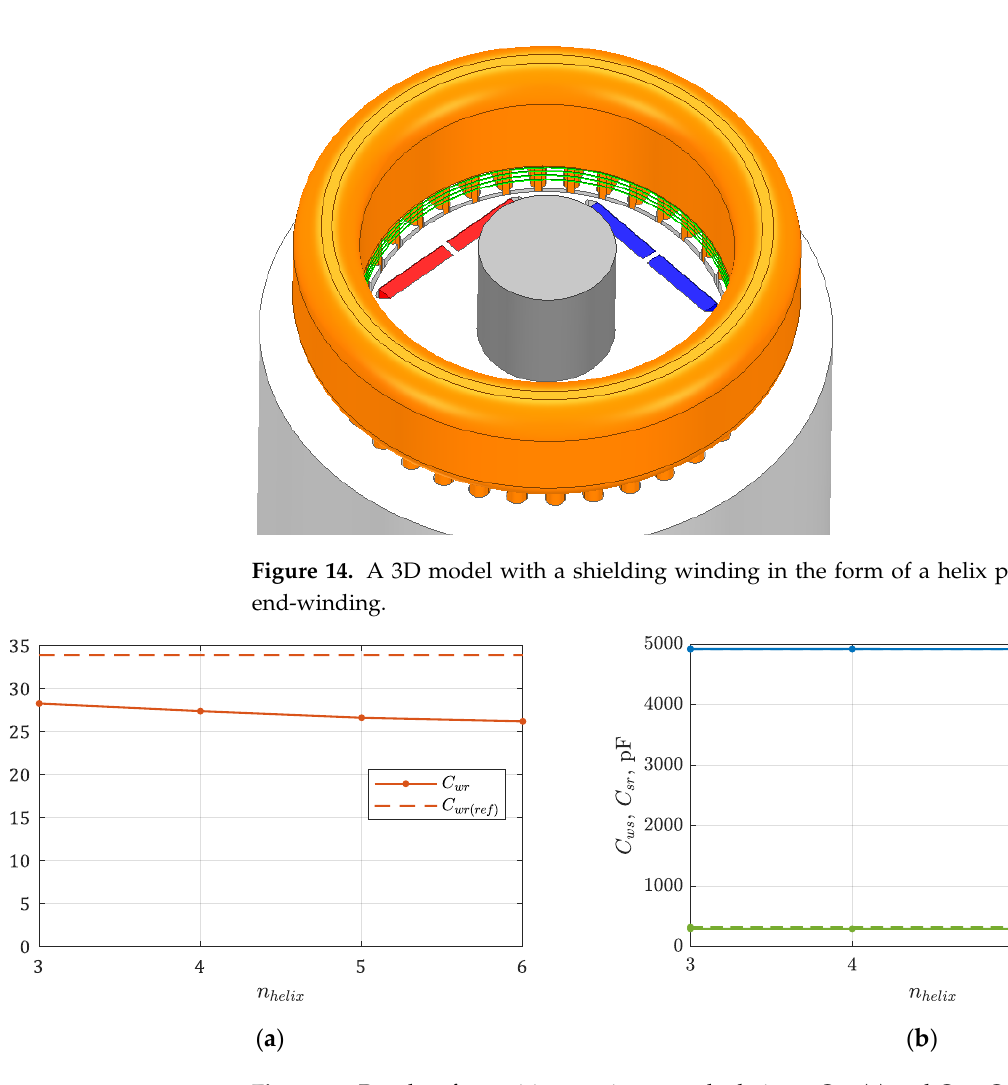
Figure 15. Results of parasitic capacitances calculations: C wr ( a ) and C ws , C sr ( b ) depending on the number of turns of the helix shielding winding n helix compared to the capacitance values of the reference model.